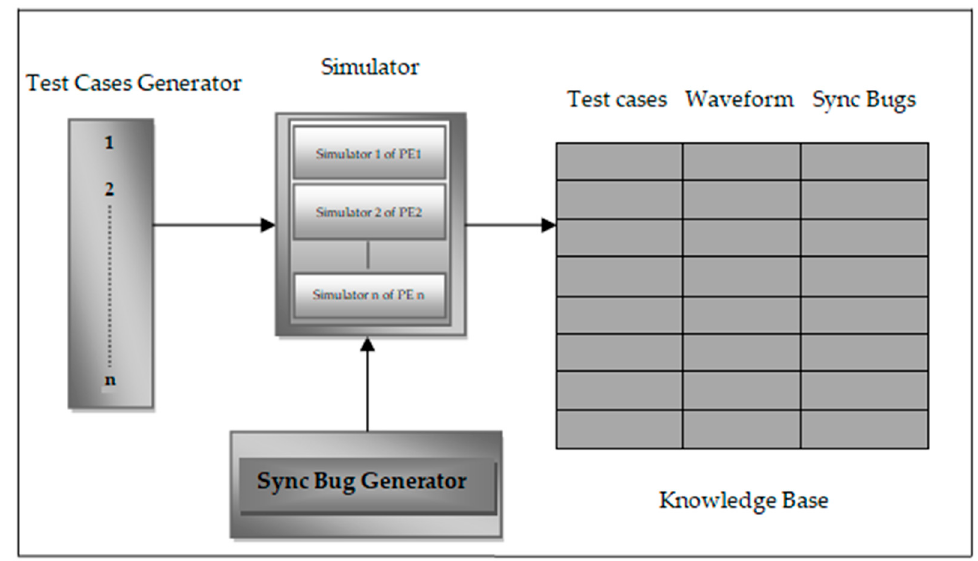
Figure 3. Simulator architecture.